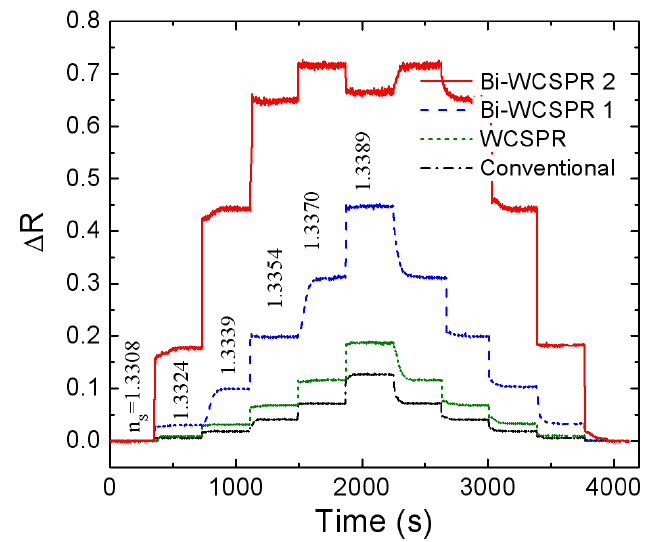
Figure 5. Temporal responses of the SPR reflectivity minima initially in pure water for each configuration as the sucrose solutions with different concentration were injected to the sensor surfaces. The refractive index of the water-sucrose solution was varied in steps from 1.3308 to 1.3389 and then back to 1.3308. The staircase profiles correspond, from top to bottom, to the responses of Bi-WCSPR2, Bi-WCSPR1, WCSPR, and conventional SPR,